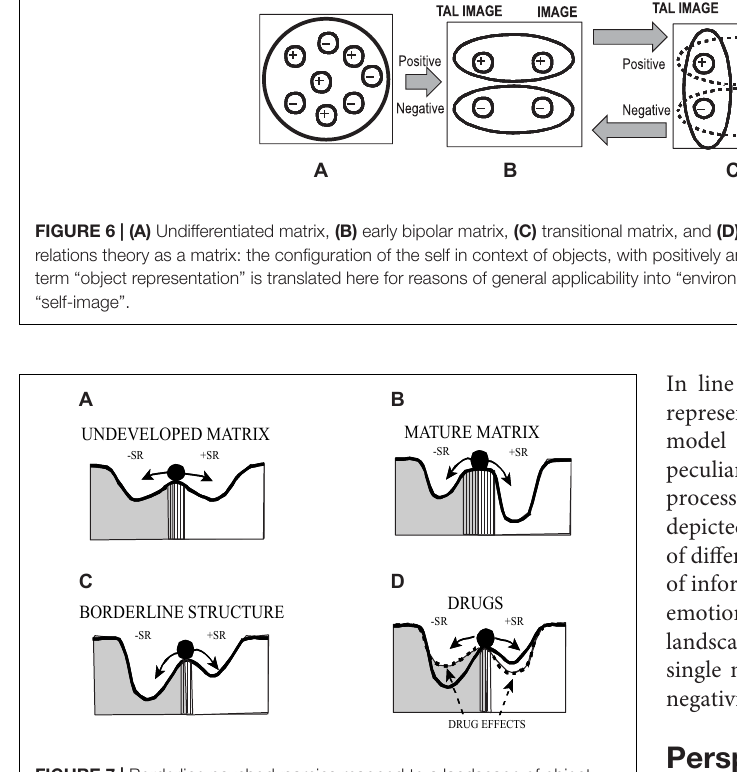
FIGURE 7 | Borderline psychodynamics mapped to a landscape of object related self-representation: Emotionally positive components and negatively loaded components of the self-image have differently strong attraction that is indicated by the deepness and steepness of the valley of the potential landscape. The respective shape determines the stability of the current mental state indicated by the black ball. During development of the person the structure of the landscape becomes more accurate (A,B) . An intermediate level of development is characteristic for borderline personality structure (C) . In this case, by drug consumption older and therefore less structured “landscapes” can arise during intoxication with confused psychotic states of experience (D) . –SR, negative self-representation; +SR, positive self-representation [adapted from Tretter (2011)]. Reproduction with permission of Schattauer